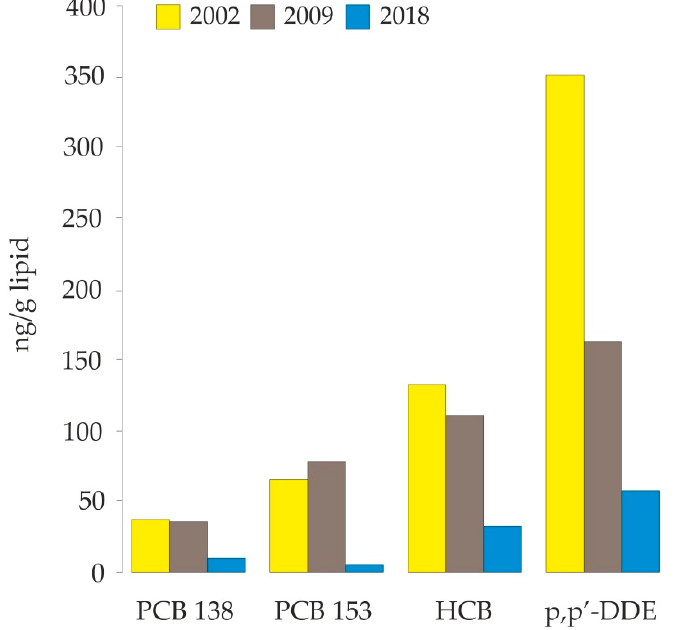
Figure 4. Concentration of selected POPs (geometric means) in serum of women from 2002 to 2018 in Nelmin-Nos, Nenets Autonomous Okrug (Russia Arctic).